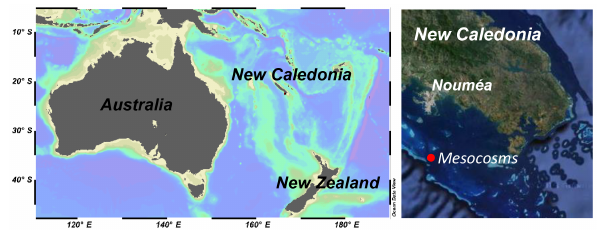
Figure 1. Location map of mesocosms deployment off Nouméa in New